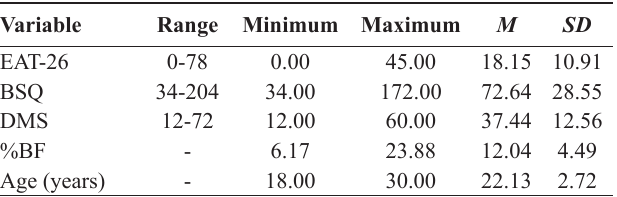
Table 1. Descriptive Values (Minimum, Maximum, Mean and Stan- dard Deviation) of Study Variables Variable Range Minimum Maximum